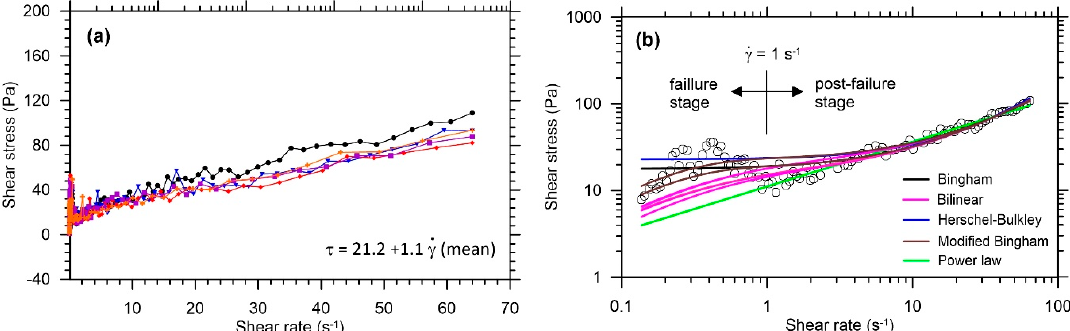
Figure 2. Flow curves and model fitting: ( a ) Shear stress and shear rate relationships with the mean value of flow equation; ( b ) model fitting with Bingham, Bilinear, Herschel–Bulkley, Modified Bingham, and Power law.